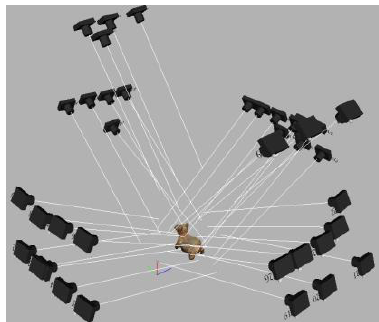
Figure 9. Spatial configuration of the image bundle The point cloud achieved from matching consists of 110.000 points, computing time was approximately two minutes. The matching result is illustrated in Figure 10: